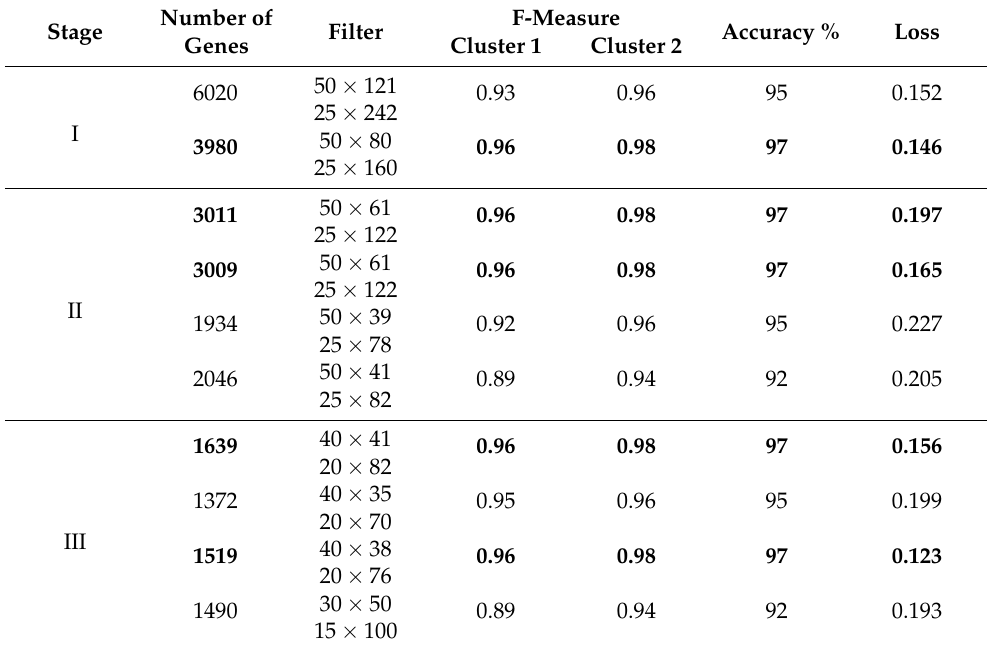
Table 3. Simulation results regarding the step-by-step application of the hybrid inductive model of GEP clustering based on the SOTA clustering algorithm and CNN.